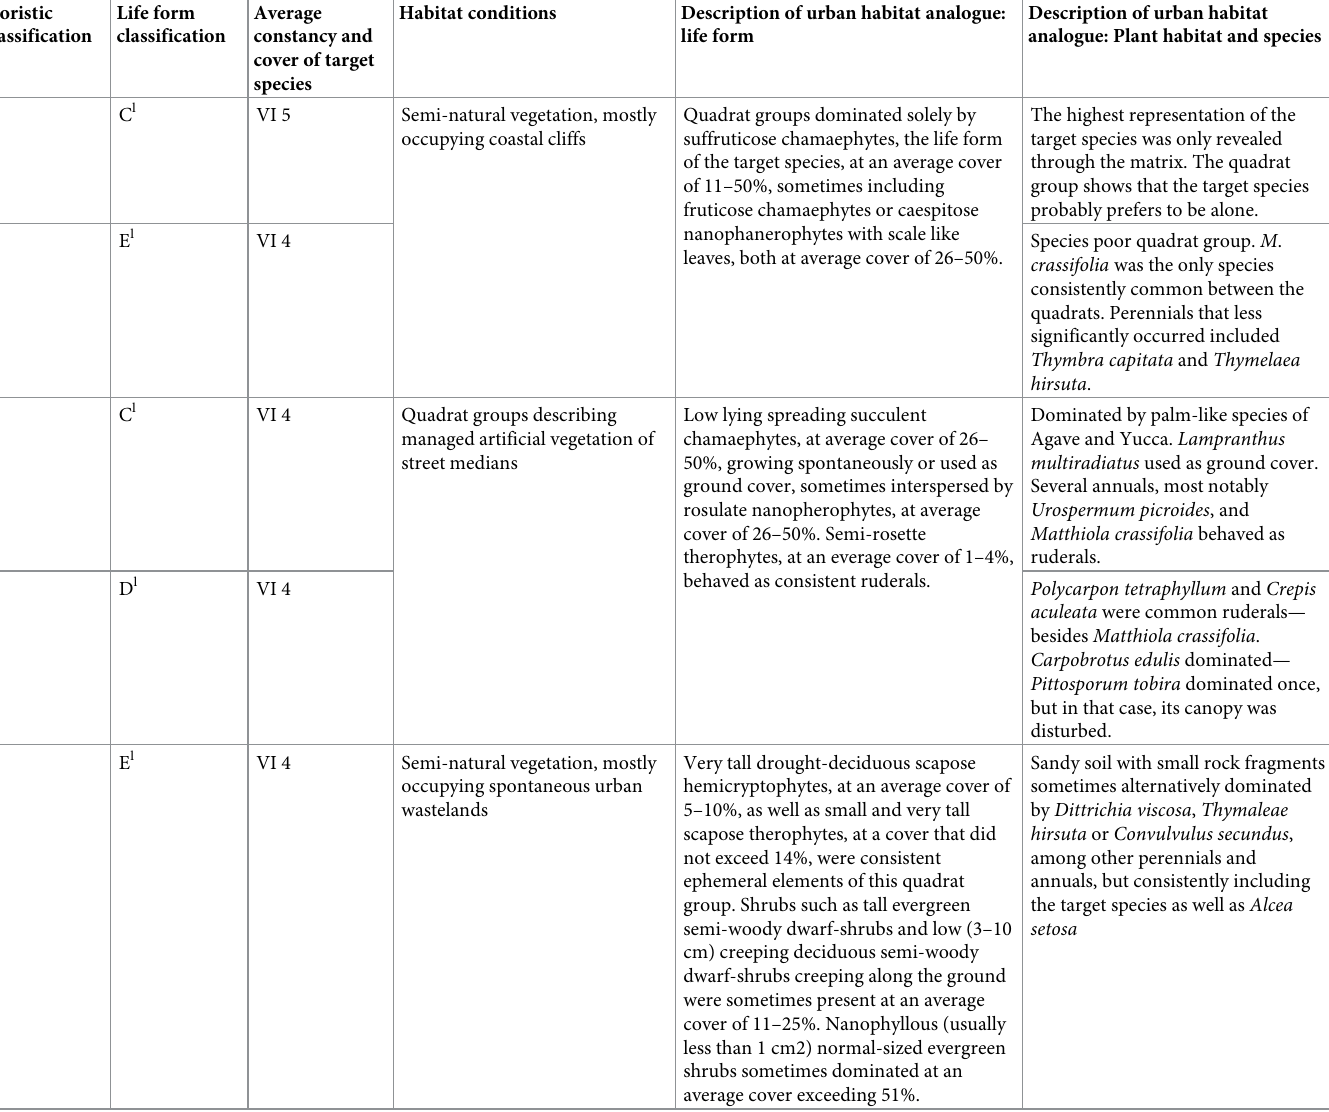
Table 3. Description of urban plant habitat analogues (habitat condition, life forms, plant habitat, and species) for M . crassifolia in Beirut following a stepwise approach that intersects floristic and life form data classifications. Floristic Life form classification